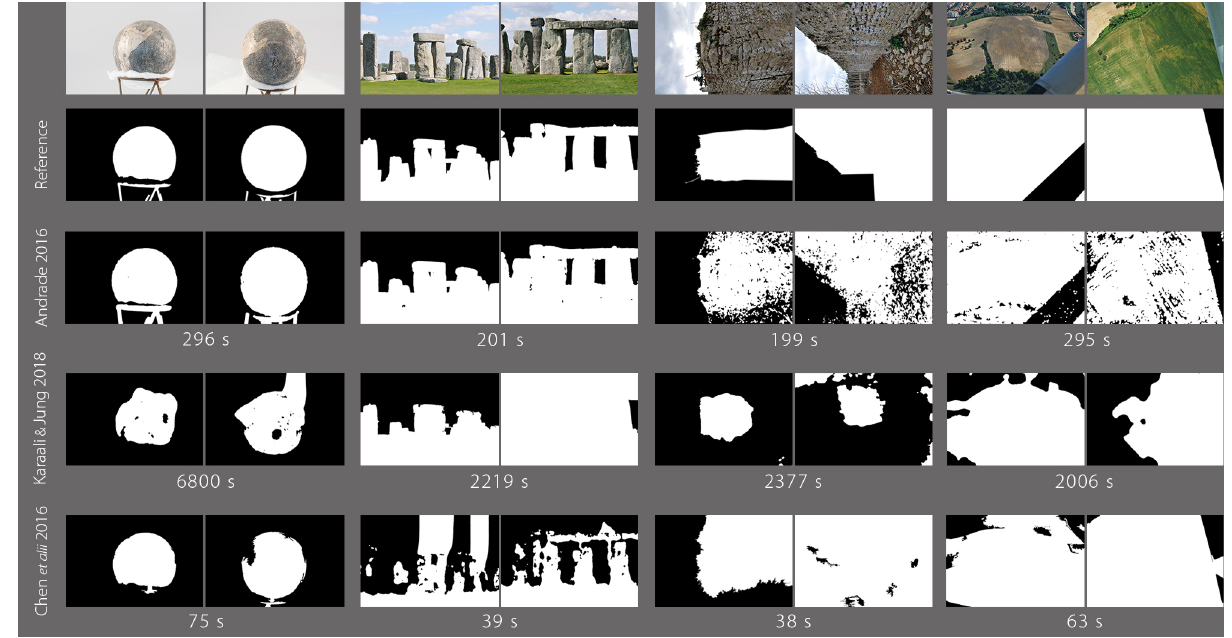
Figure 6. Comparison of the automatically generated binary image masks with a reference mask across four image sets. The masks were generated after thresholding a full defocus map that was computed by three different methods (mentioned on the left). The average running time for one type of image is displayed for every method. Finally, black means masked, white means not